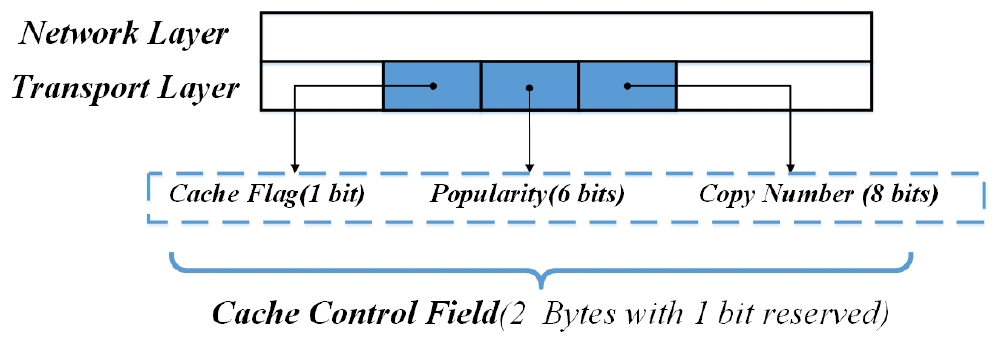
Figure 2. Cache-Control field design.